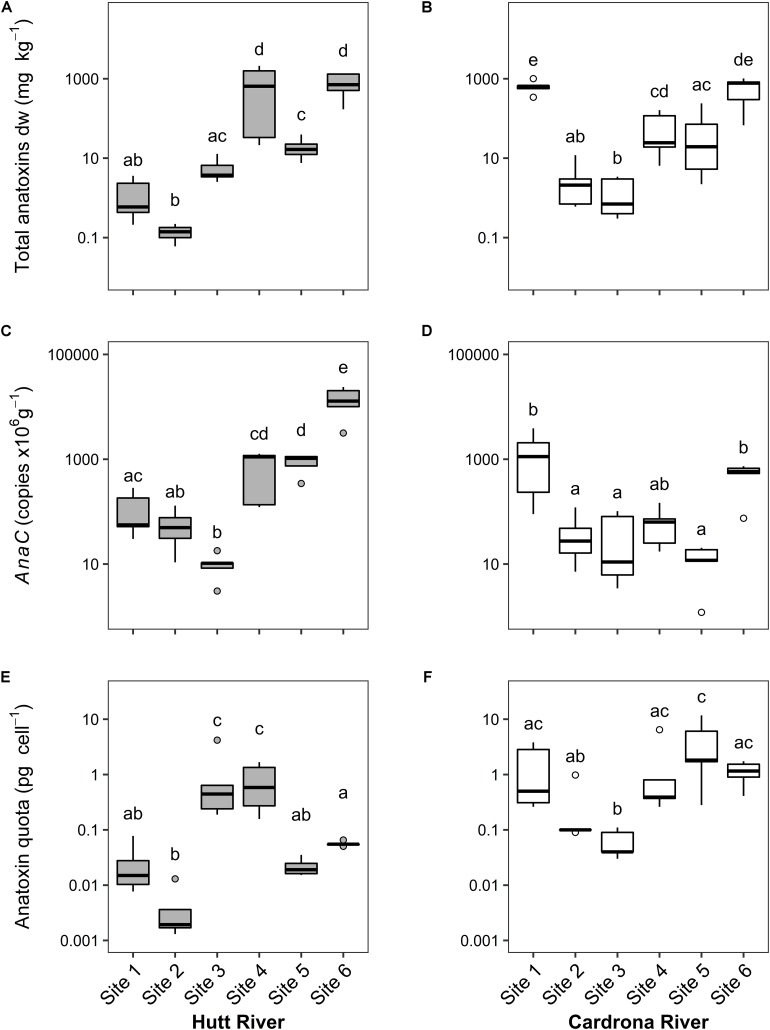
(A,B) Total anatoxin (i.e., the sum of the four anatoxin congeners); (C,D) concentrations of anaC copy numbers; and (E,F) anatoxin quotas (amount of toxin per toxic cell) from Microcoleus autumnalis-dominated mats collected from sites along the Hutt River (Wellington, New Zealand) or the Cardrona River (Otago, New Zealand). Sites are arranged along x-axis in an upstream (left) to downstream (right) gradient. n = 5 for all sites except for Hutt River site 4 (n = 4). Note that y-axes are different log scales. Solid black lines indicate the median, box shows 1st and 3rd quartiles, whiskers extend to the last data point within 1.5 times the inter-quartile range. Open circles are outliers beyond this range. Shared letters indicate no significant difference (p > 0.05) between sites (One-way ANOVA, Tukey HSD). Dw, dry weight; pg, picograms.